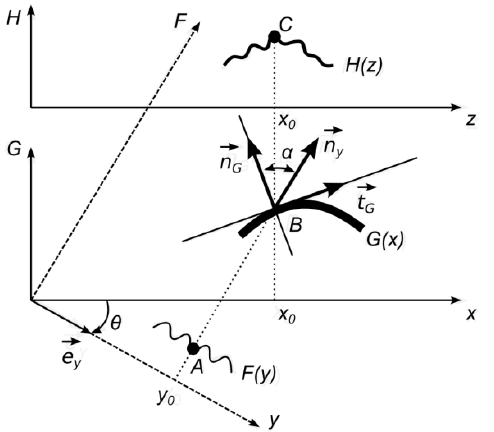
Figure 7. One-dimensional geometrical representation of optical projection on a diffuse surface. F(y) projected image, G(x) diffuse deformed surface, H(z) observed